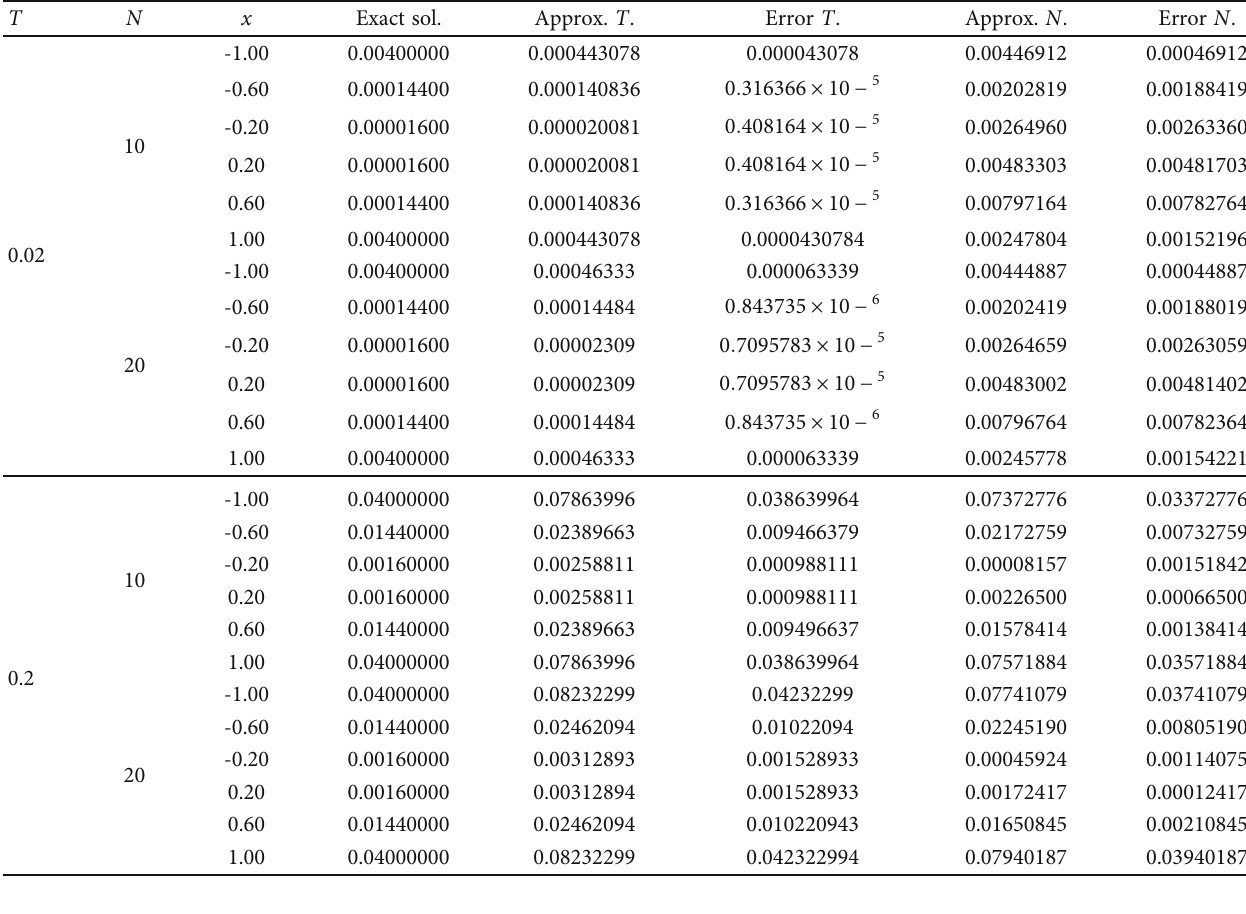
Table 2: The values of exact, approximate, and absolute error values by TMM and PNM for (Plutonium υ = 0 : 21 ). T N x Exact sol. Approx. T . Error T .